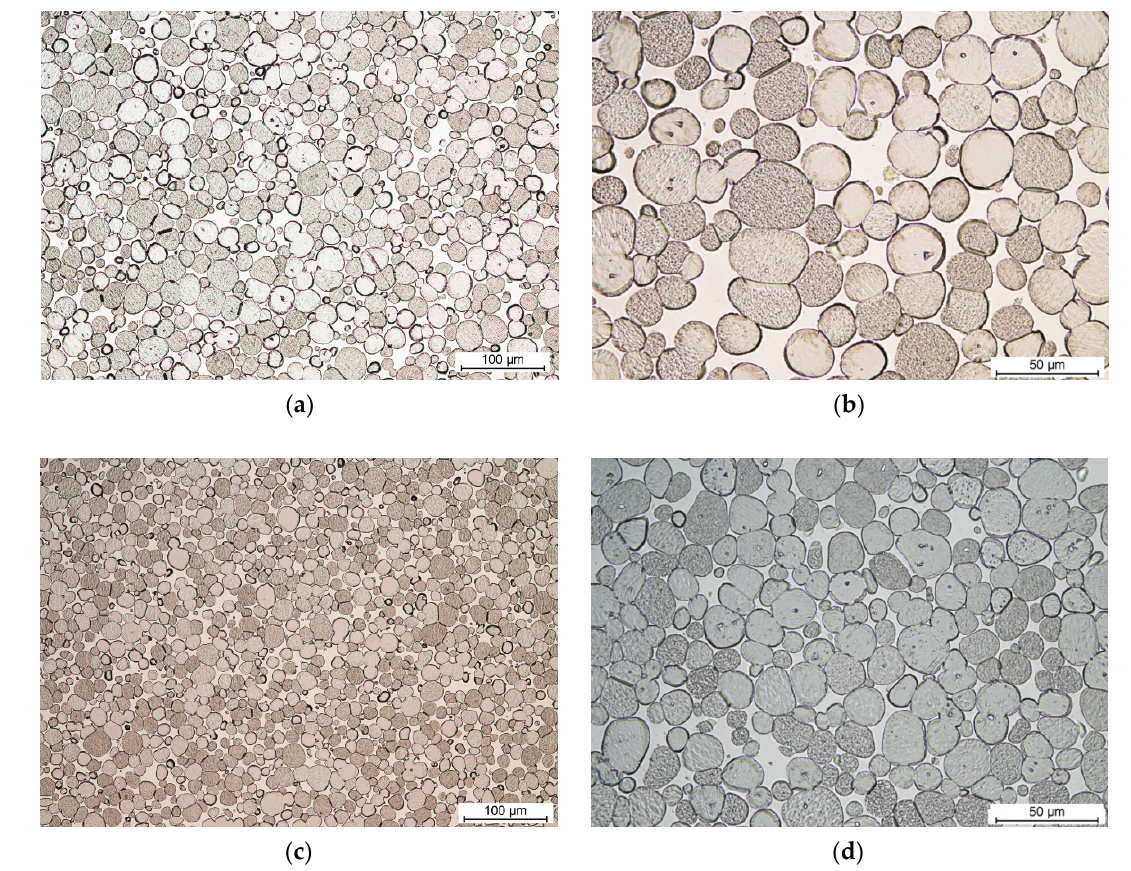
Figure 6. The microstructure of THA: ( a , b ) without addition of Re (PR-100), ( c , d ) with 2.4 wt.% Re (Re-3), ( a , c ) mag. 200×, and ( b , d ) mag. 500×.